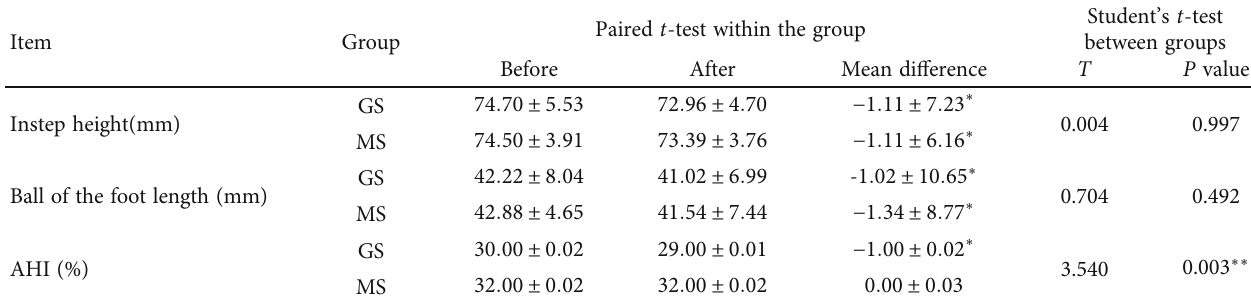
Student ’ s t -test between groups